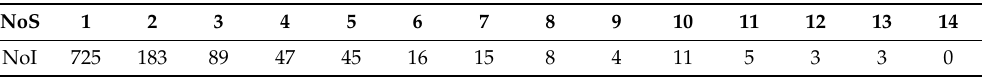
Table 1. Corresponding relationships between NoS and NoI in SSDD.